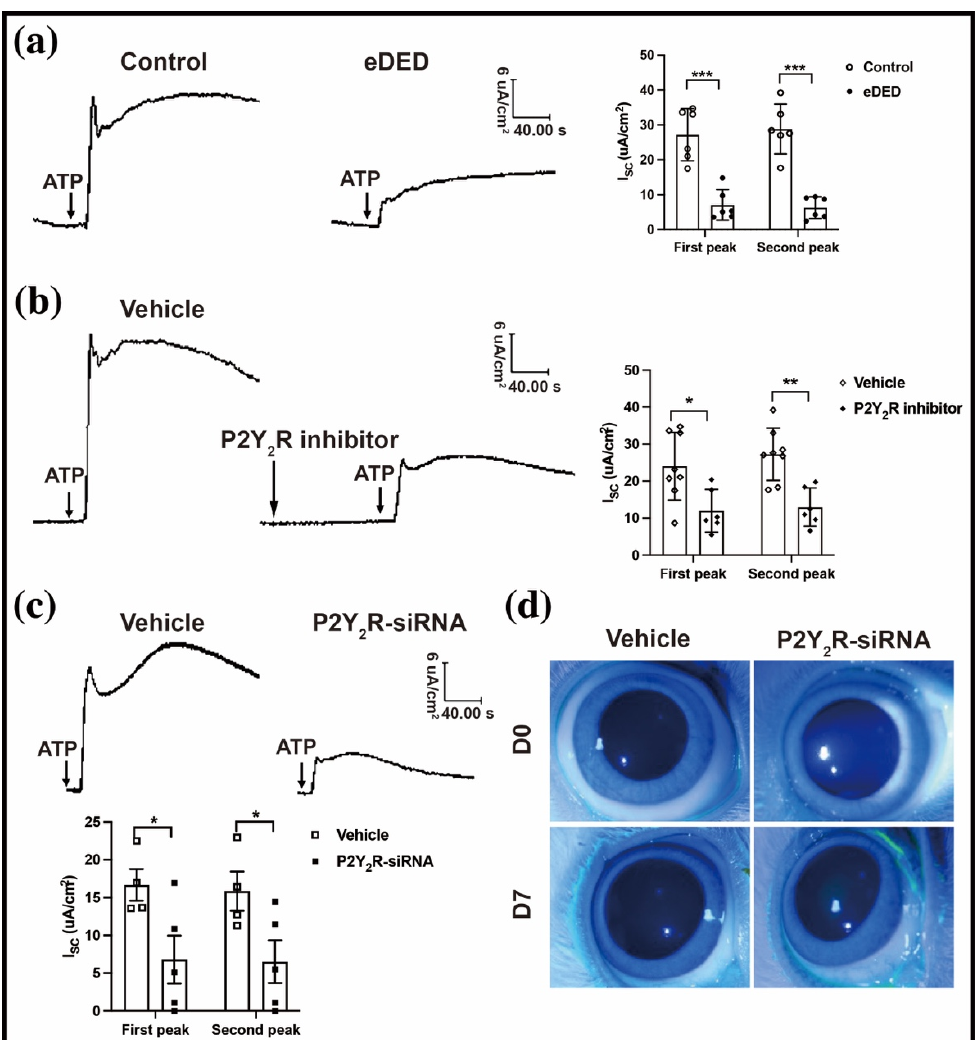
Figure 3. P2Y 2 R is indispensable for conjunctival fluid secretion. ( a ) Left, representative images of ATP-induced conjunctival Isc in the control and eDED groups; right, bar graph showing the first and second peaks of ATP-induced conjunctival Isc in the control and eDED groups, n = 6 in each group. ( b ) Left, representative images of ATP-induced conjunctival Isc of the vehicle and P2Y 2 R antagonist (suramin) groups; right, bar graph showing the first and second peaks of ATP-induced conjunctival Isc in the vehicle (n = 8) and P2Y 2 R antagonist groups (n = 6). ( c ) Top, representative images of ATP-induced conjunctival Isc in the vehicle and P2Y 2 R-siRNA groups. Bottom, bar graph showing the first and second peak of ATP-induced conjunctival Isc in the vehicle (n = 4) and P2Y 2 R-siRNA group (n = 5). ( d ) Representative images of cornea fluorescein in the vehicle and P2Y 2 R-siRNA group. Data are represented as mean ± SEM. * p < 0.05, ** p < 0.01, *** p < 0.001.